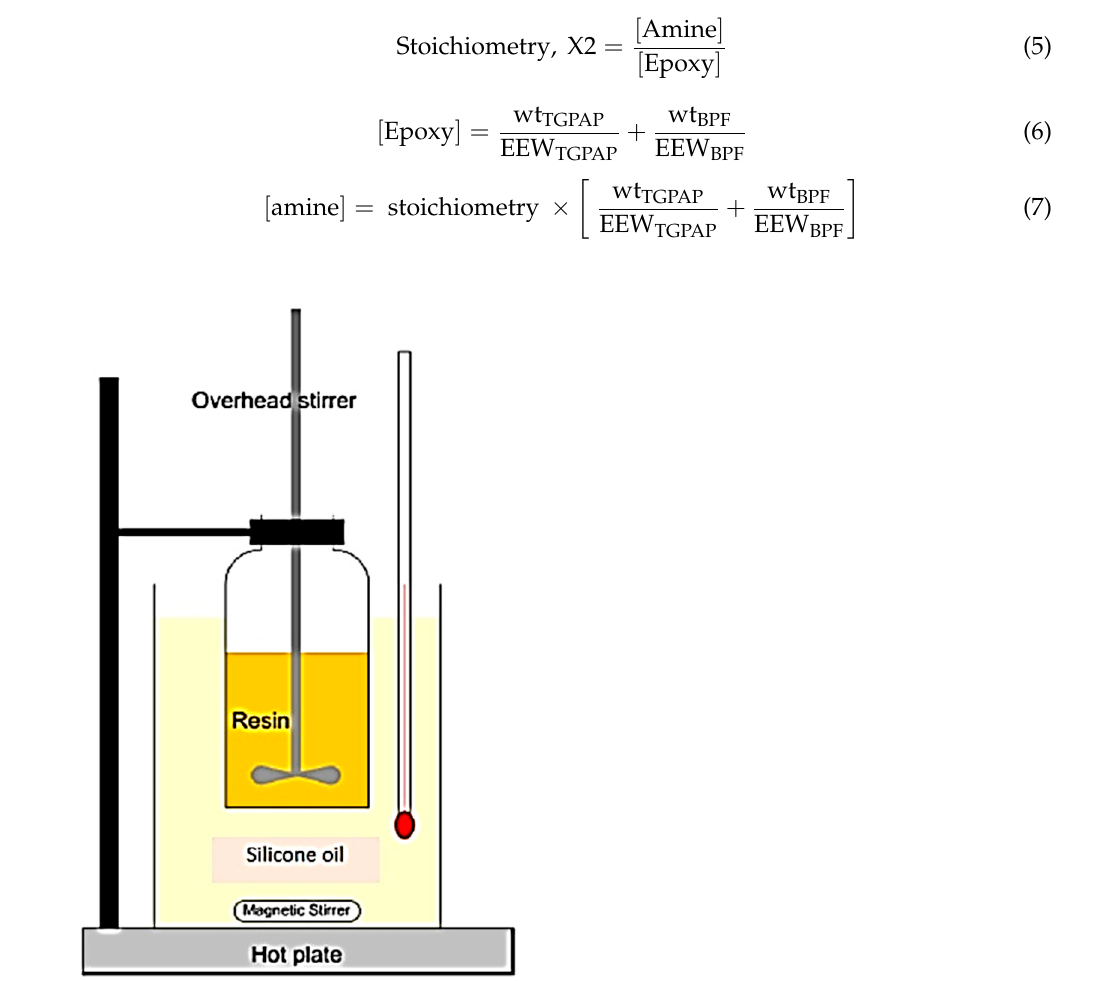
Figure 4. Chemical structure of 4, 4 ′ -diaminodiphenyl sulfone (DDS).